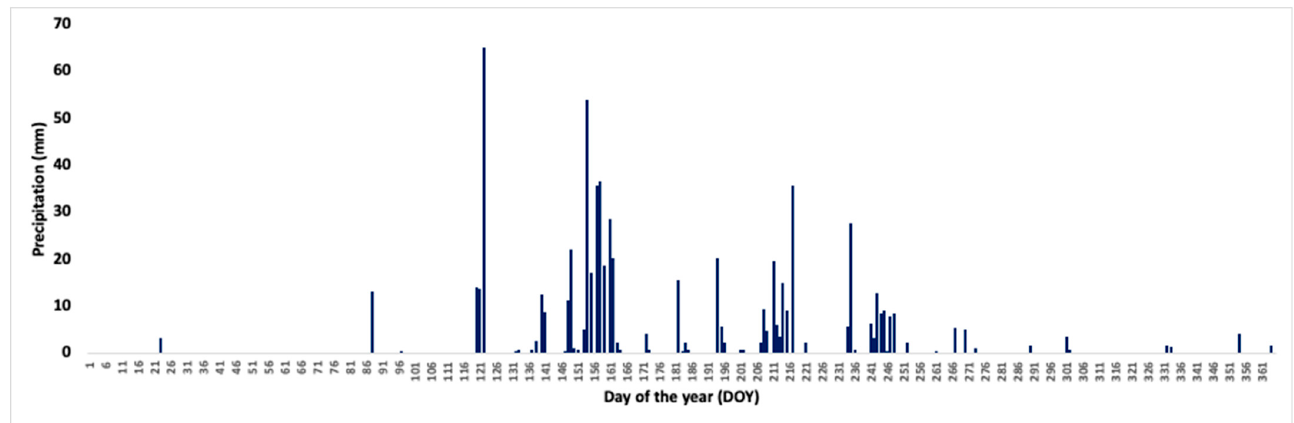
Figure 1. Annual accumulated precipitation (mm) of the blueberry ( Vaccinium corymbosum L. ‘Duke’ and ‘Star’) plot.